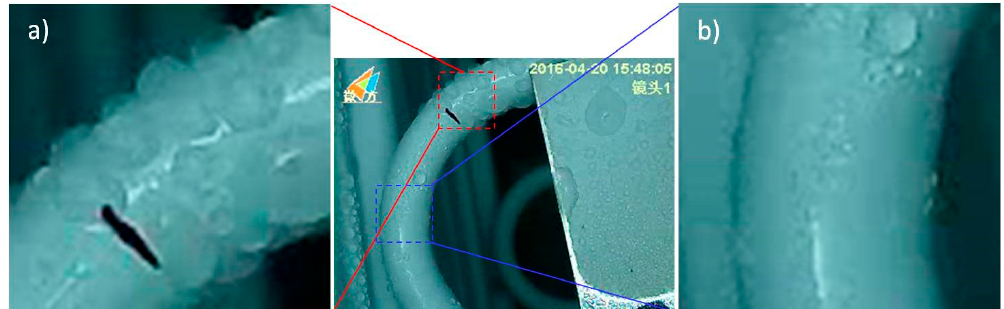
Figure 9. Condensation of defrost droplets on the evaporator with different surface conditions: ( a ) normal surfaces; ( b ) PDMS-SiO 2 /PFA hybrid coating surfaces. Note: 微 方 is a brand and 镜 头 1 means camera No.1.